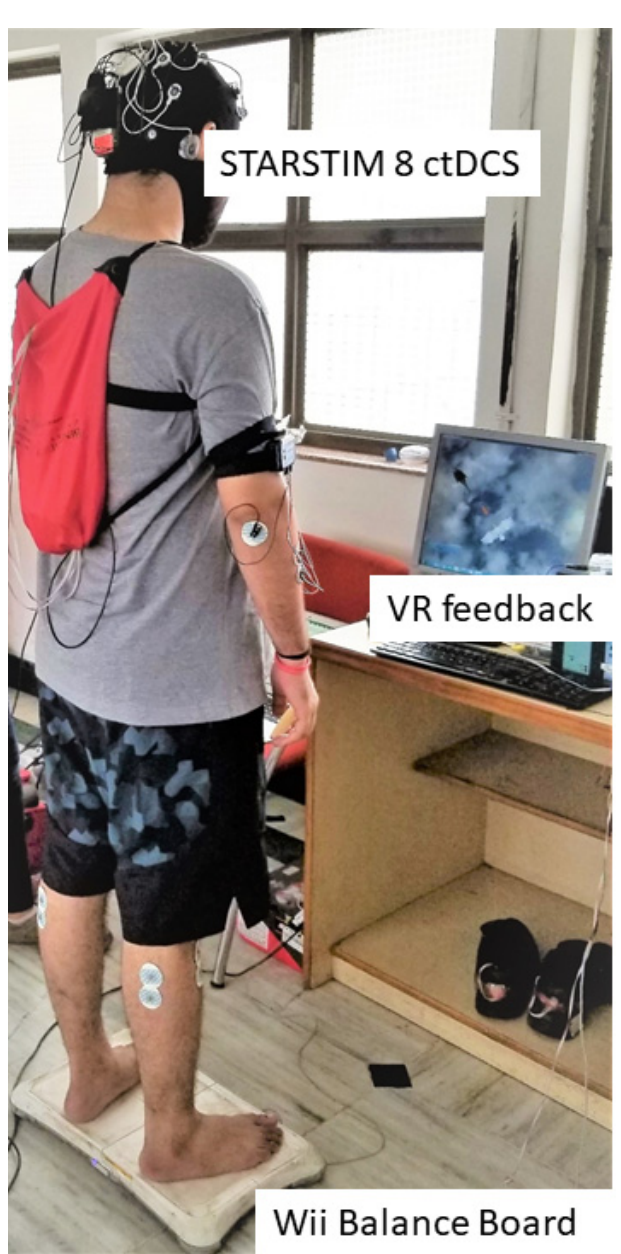
Figure 1. Portable experimental setup for the clinical study consisting of the Wii Balance Board to measure the center of pressure (CoP), a small form factor desktop PC with monitor for the virtual reality (VR) balance testing and training based on CoP. And the wireless STARSTIM 8 simulator for cerebellar transcranial direct current stimulation (ctDCS).